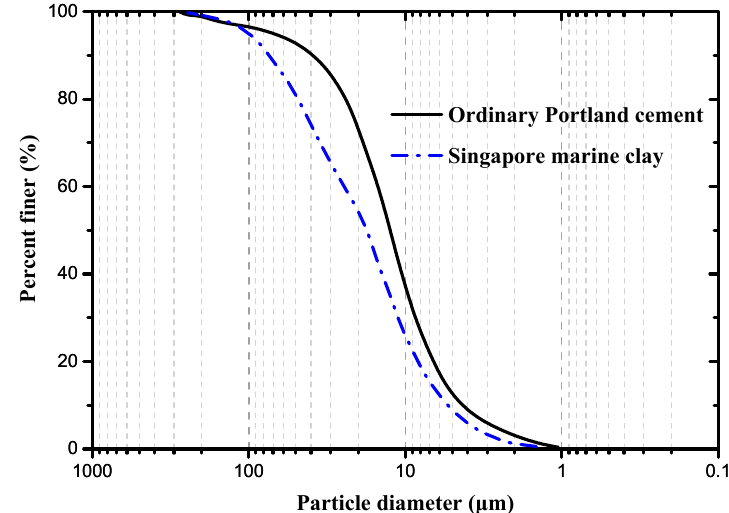
Figure 2. Particle size distribution of ordinary Portland cement and Singapore marine clay (the particle size distribution data are from Du and Pang [48]).